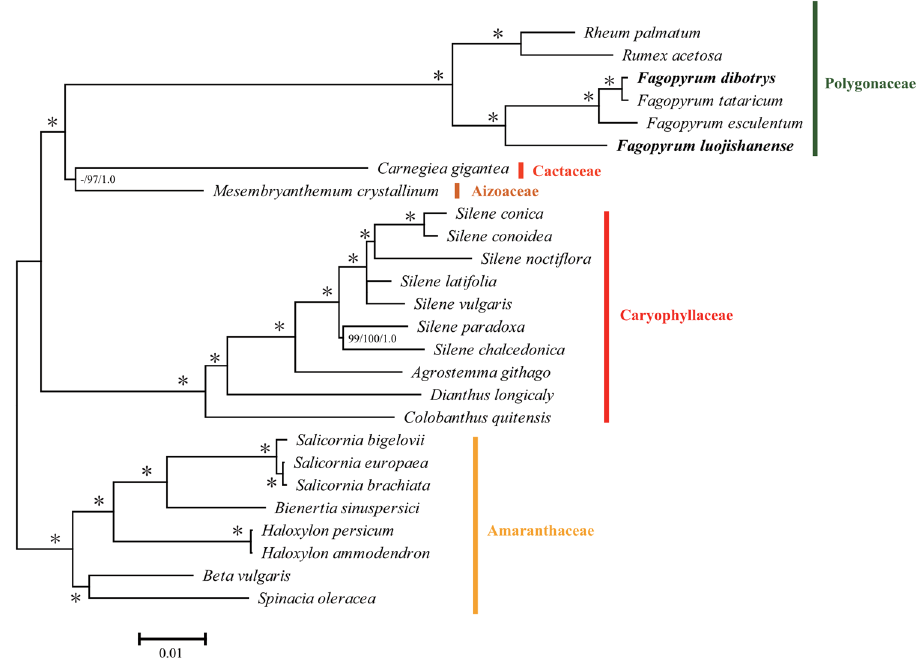
Figure 6. Phylogenetic relationships of the four Fagopyrum species inferred from MP/ML/BI analysis constructed by chloroplast genome. The numbers associated with each node are bootstrap support values, and the symbol * in the phylogenetic tree indicated that the support rate of branch is